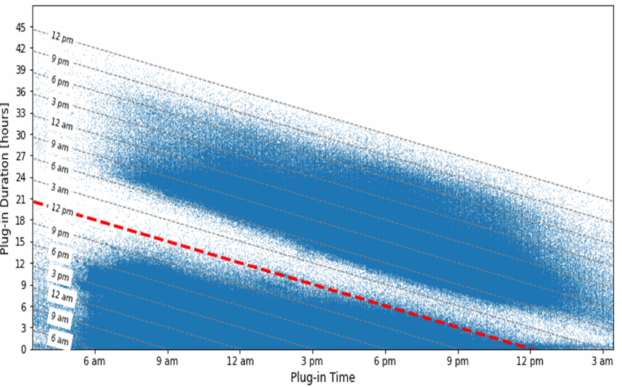
Figure 6. Final adjusted data depending on plug-in time and plug-in duration, red dashed line represents midnight.